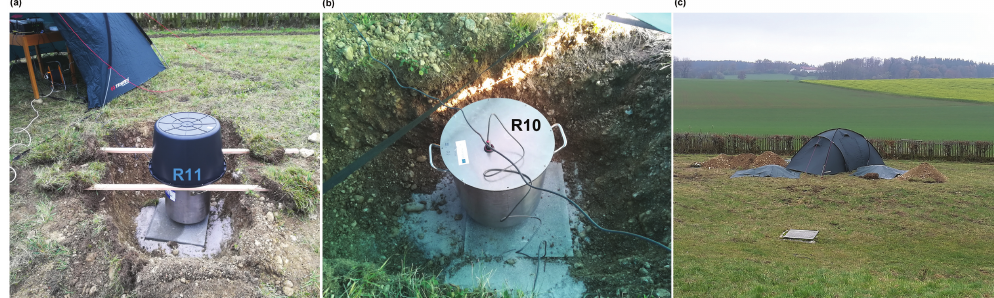
Figure 6. Field deployment of the Rotaphones-CY involved in the Geophysical Observatory in Fürstenfeldbruck (GOF) experiment: ( a ) Rotaphone R11, NW apex of the triangular array, before the waterproof foil was laid over, ( b ) the central Rotaphone R10, sheltered by a tent, and ( c ) the whole array as viewed from the North, R10 inside the tent, R8 and R11 on both sides, R13 hidden behind the tent.